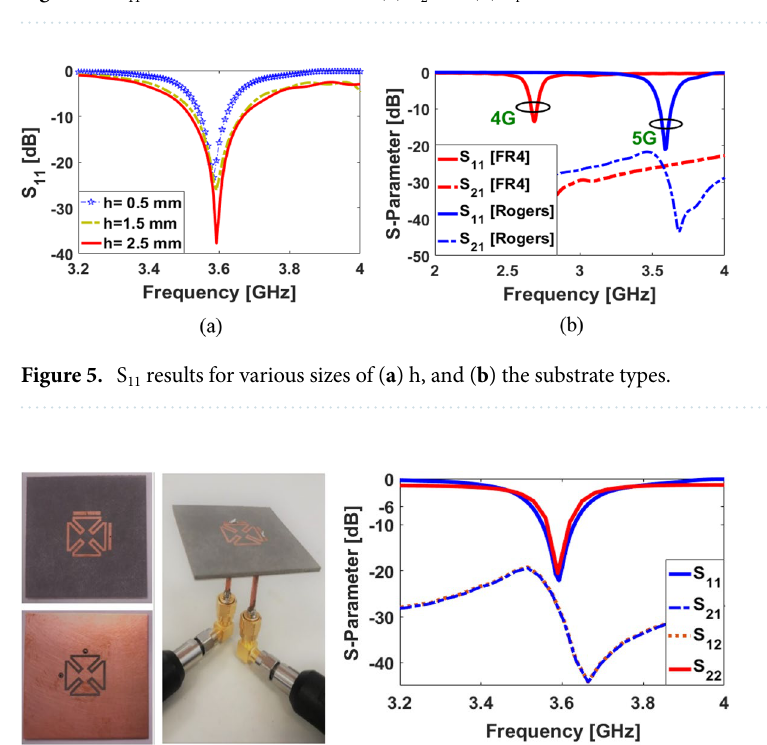
Figure 4. S 11 results for various sizes of ( a ) L 2 and ( b ) L f .